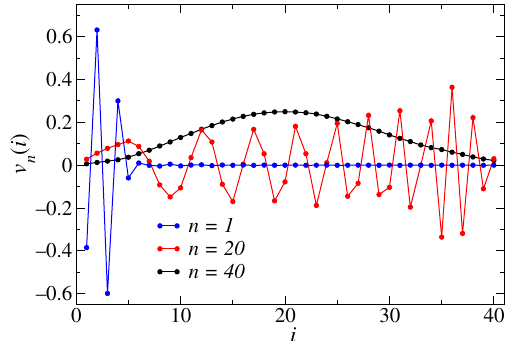
FIG. 23. The eigenvectors corresponding to the smallest ( n ¼ 1 ) and largest ( n ¼ 40 ) eigenvalues of the covariance matrix in Fig. 22, as well as one from the middle of the eigenvalue spectrum ( n ¼ 20 ).